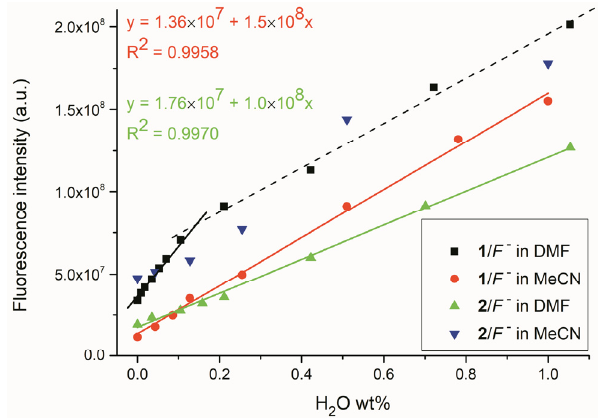
Figure 6. Fluorescence intensity behaviour of studied two-component coumarin oxime sensors 1 /F − and 2 /F − in MeCN and DMF during titration with water ( λ EX = λ A(oxime) ; T = 298.15 K).